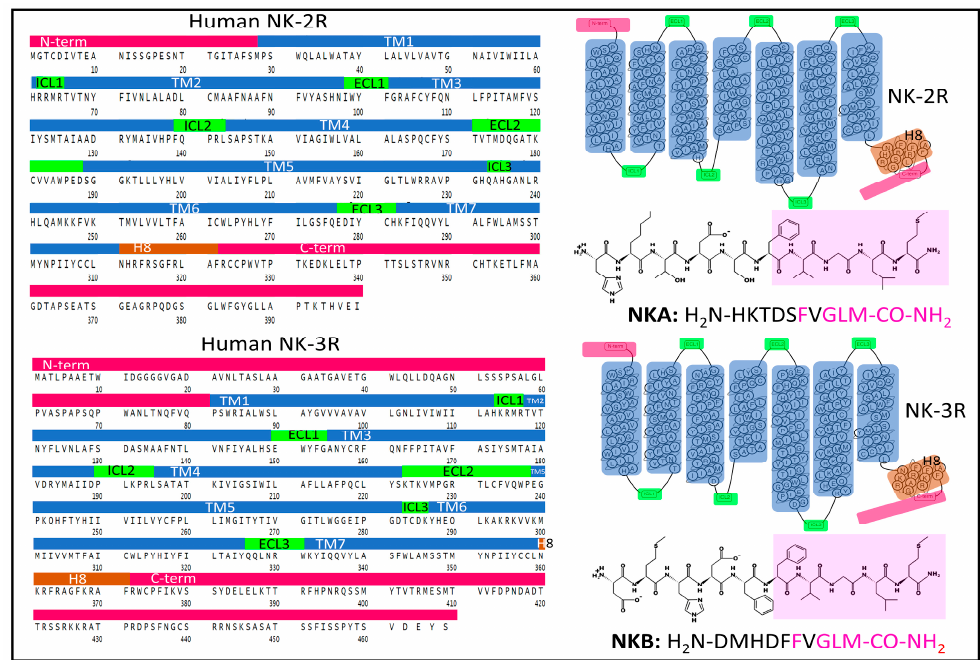
Figure 3. Complete sequences and snake plots of the neurokinin receptors 2 and 3 and their preferential endogenous agonists, NKA and NKB. The domains of NK-2R and NK-3R (N- and C-terminal regions, transmembrane helices (TM), Helix 8, and intra- and extracellular loops) are highlighted in color. Color areas illuminate the amino-acid sequence of the C-terminal end of neurokinins. The sequences and structures of the receptors are from the GPCR database [47], and the peptide structures were drawn with KingDraw software (Version 1.1.0 ) [48].